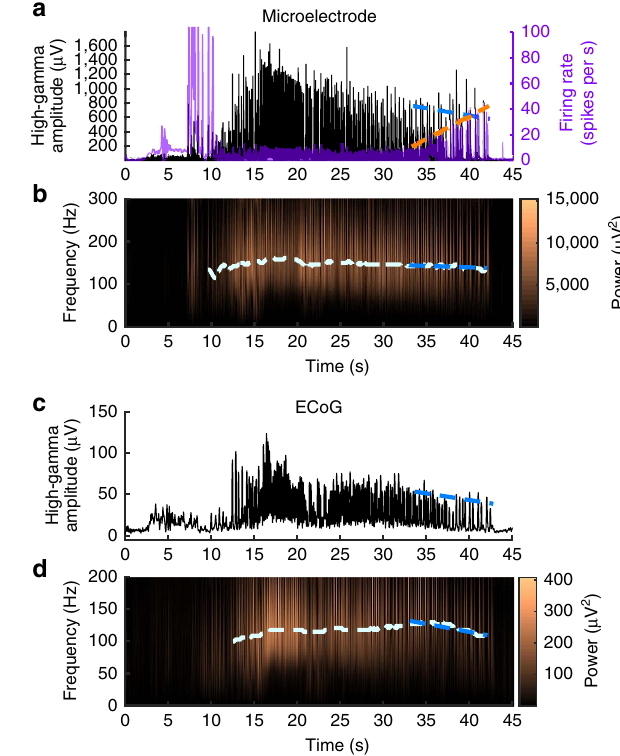
Figure 5 | Decreasing input to a network of simulated neurons recreates mean-field dynamics observed in the data. ( a ) Mean firing rate of the simulated ictal network progresses from tonic firing, to rhythmic discharging, to self-termination, with decreasing extra-network input. The colours correspond to the epochs labelled in Fig. 1 as apparent in the model’s firing rate. ( b ) Firing rate from all microelectrode channels during one spontaneous human seizure, showing the progression from tonic firing during ictal wavefront passage, to rhythmic discharging, to seizure termination. The coloured bars above the seizures correspond to the epochs labelled in Fig. 1. ( c ) Peak mean firing rate during each discharge in the pre-termination period for the simulated neurons (green) and the seizure shown in b (purple). ( d ) Inter-discharge intervals during the pre- termination period, for the simulated neurons (green) and the seizure shown in b (purple). ( e ) Discharge width during the pre-termination period, for the simulated neurons (green) and the seizure shown in b (purple).